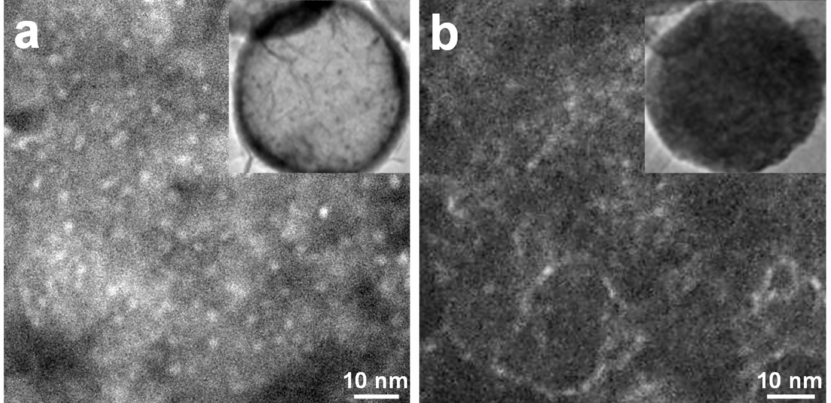
Figure 6. High resolution transmission electron microscope (HR-TEM) micrographs of microspheres synthesized at ( a ) 150 ◦ C and ( b ) 300 ◦ C. Hierarchical structure with nanopores is present in graph ( a